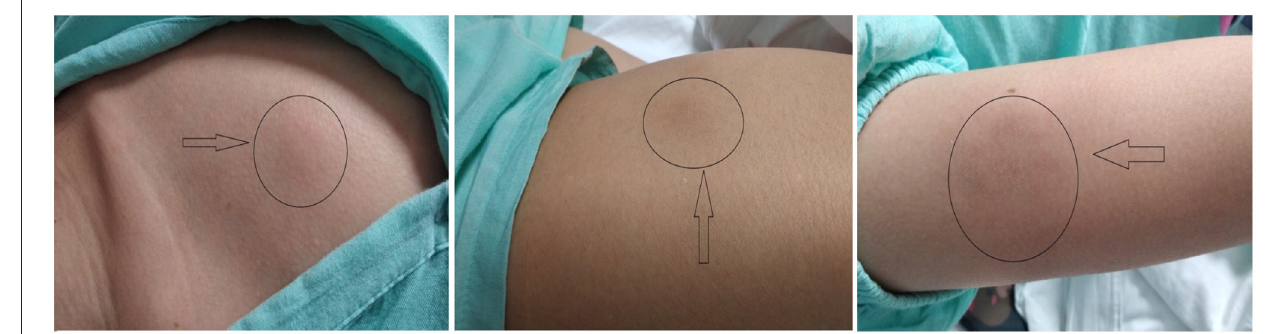
FIGURE 1 | Characteristic clinical